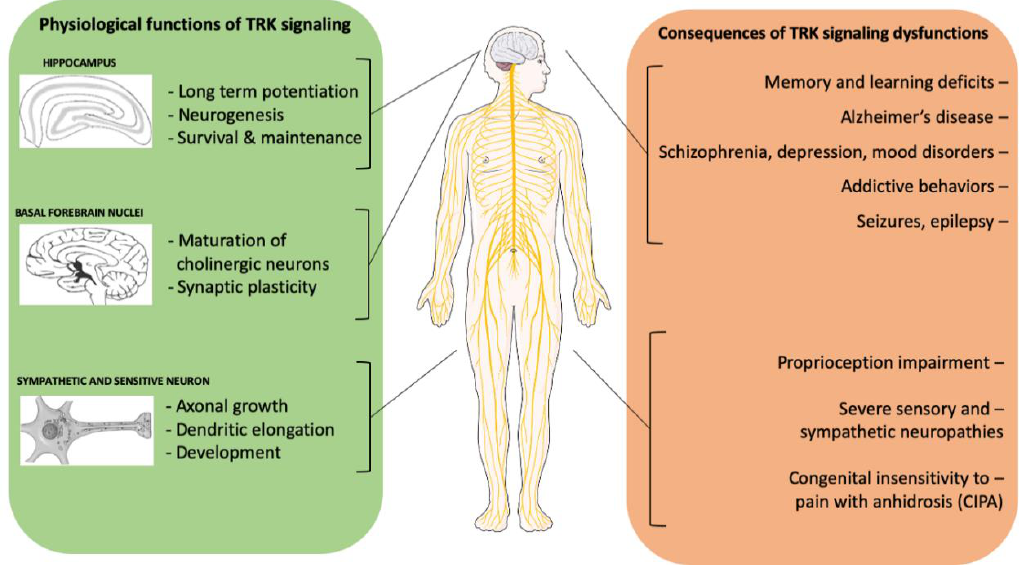
Figure 2. Neurophysiological functions of TRK signaling and possible consequences of its alterations.